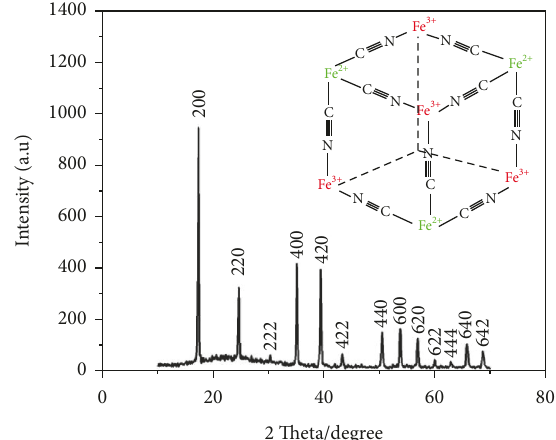
Figure 1: XRD pattern of Prussian blue nanocrystal.